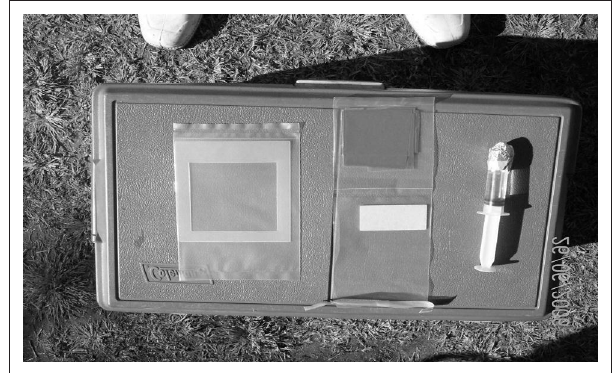
FIGURE 1: The sampling equipment for the biotrace cattle and swine